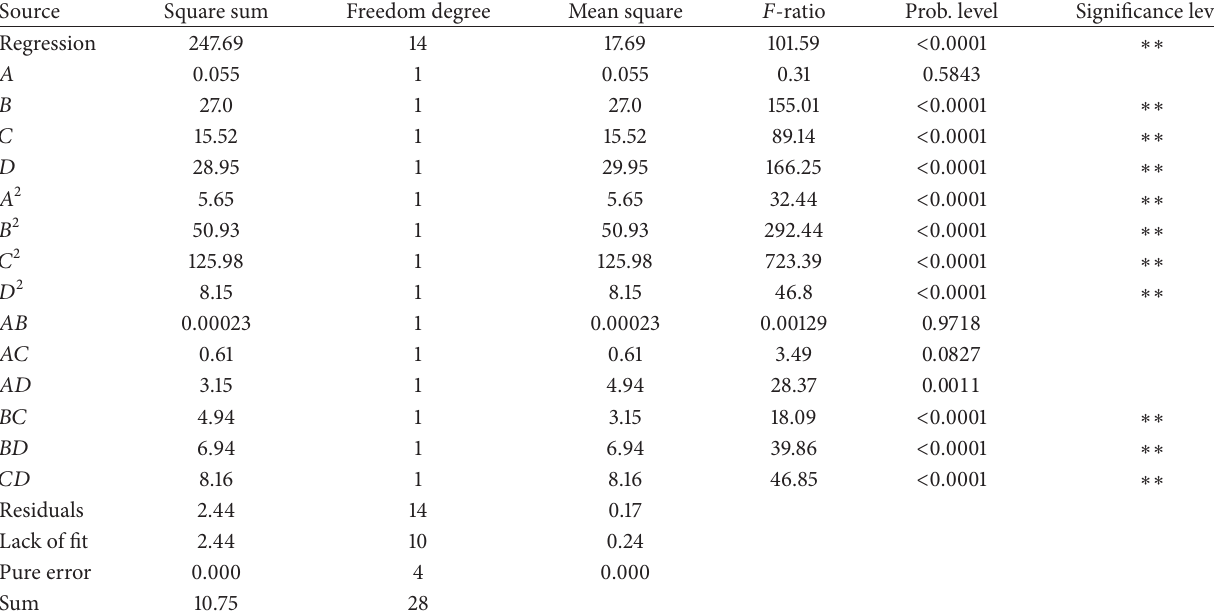
Table 3: Variance analysis of response surface test.